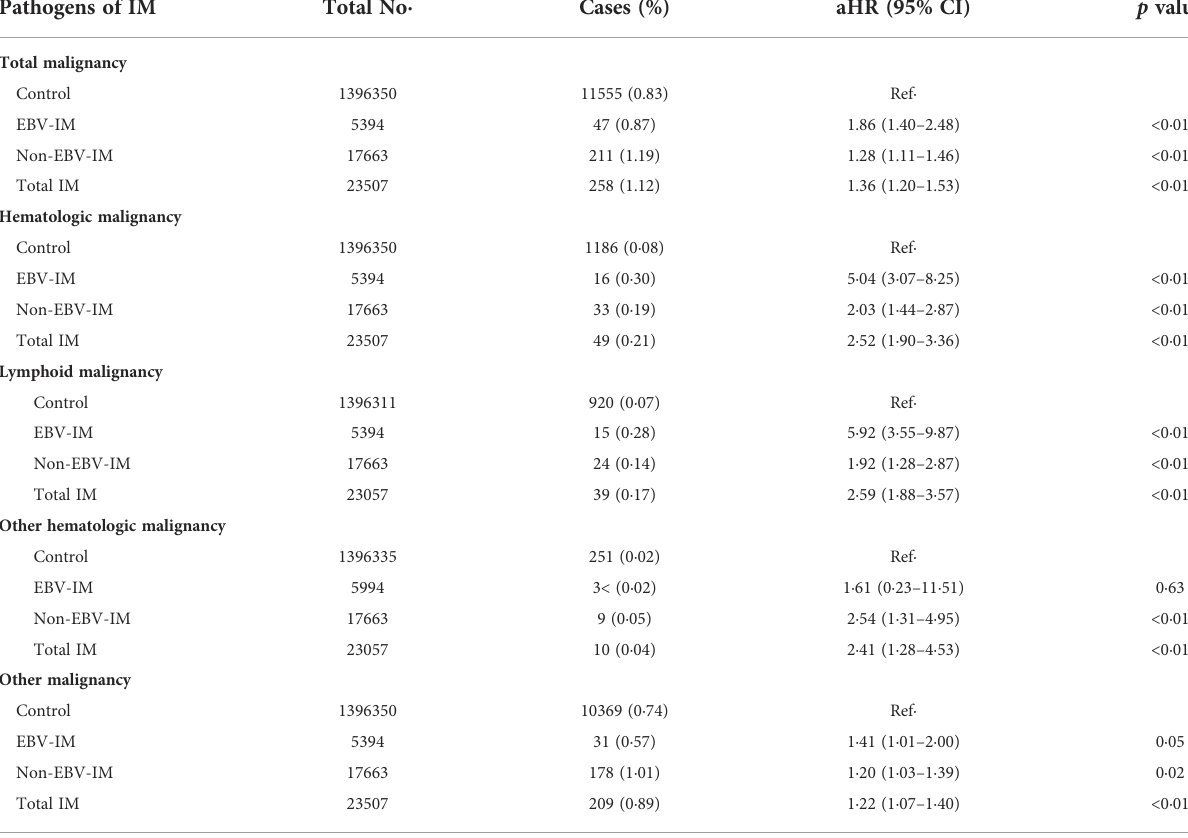
TABLE 2 Risks of subtypes of malignancy according to Infectious Mononucleosis (IM) from different pathogens.